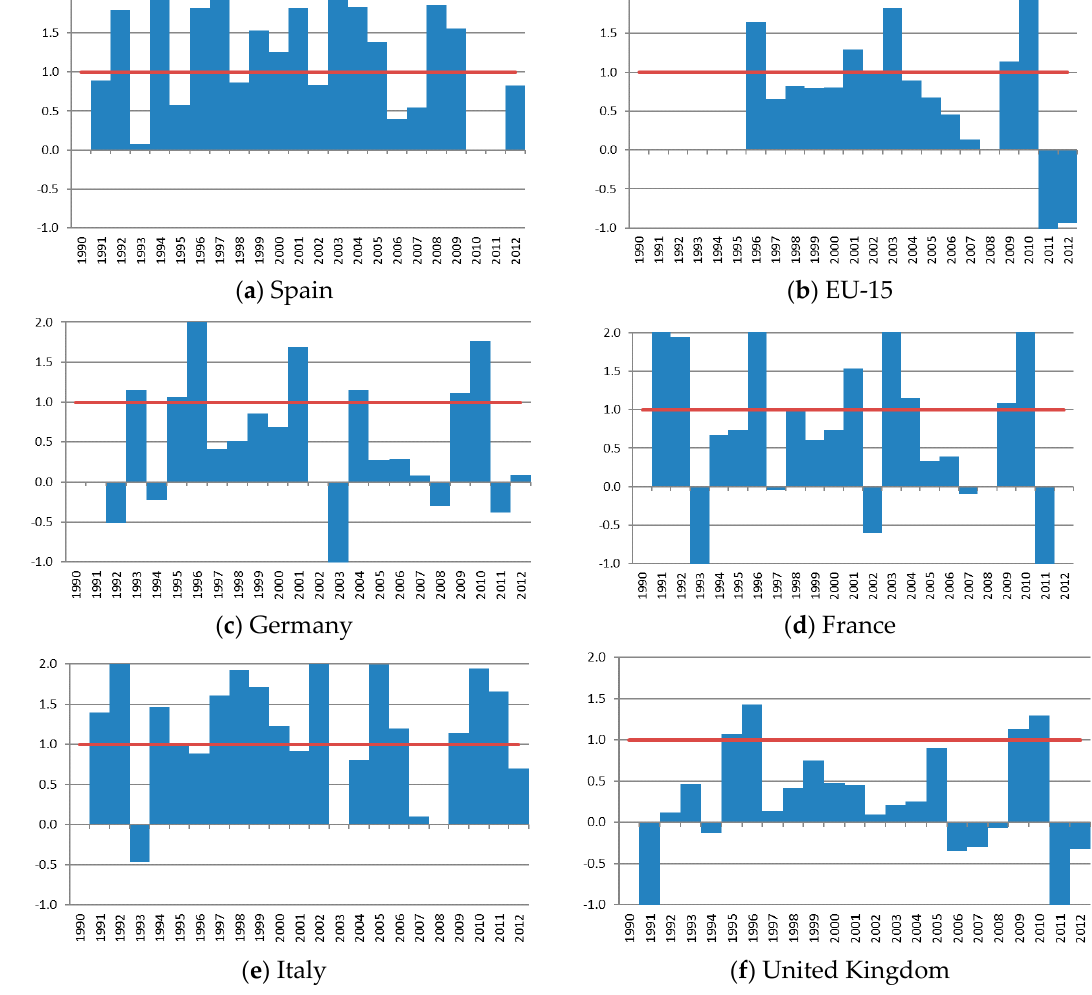
Figure 2. Elasticity Demand to GDP in selected countries. Annual data. Source: Own calculations with Eurostat data.